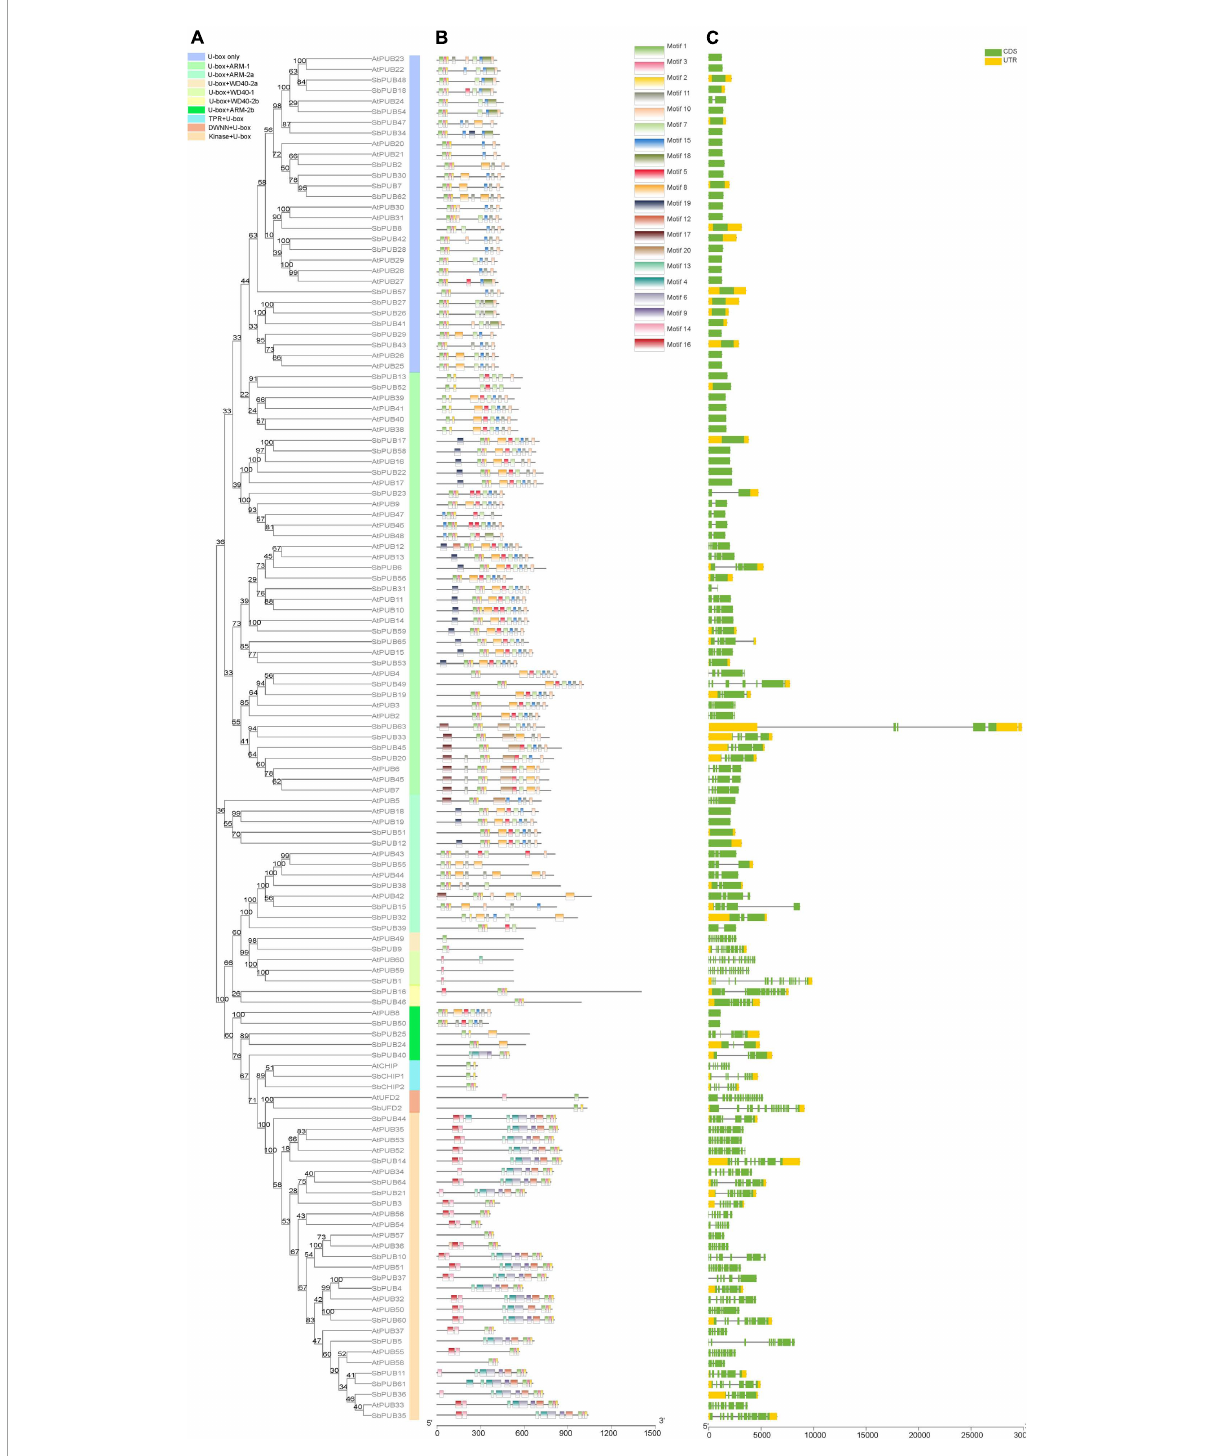
FIGURE2 Motif and structural analysis of U-box gene family members in Sorghum and Arabidopsis . (A) Phylogenetic relationships between U-box genes of Sorghum bicolor and Arabidopsis thaliana . Rootless trees were generated by the neighbor-joining (NJ) method in MEGA7 software. Numbers next to branches indicate 1,000 bootstrap replicates as a percentage. Different background colors represent different subfamilies. (B) Motifs in U-box genes. Different colored rectangles represent 30 different motifs, as shown in the color legend in the upper right corner. (C) Structural analysis of U-box genes. Green and yellow indicate coding sequence (CDS) and untranslated region (UTR) features, respectively, and the horizontal line represents gene regions, as shown in the color legend in the upper right